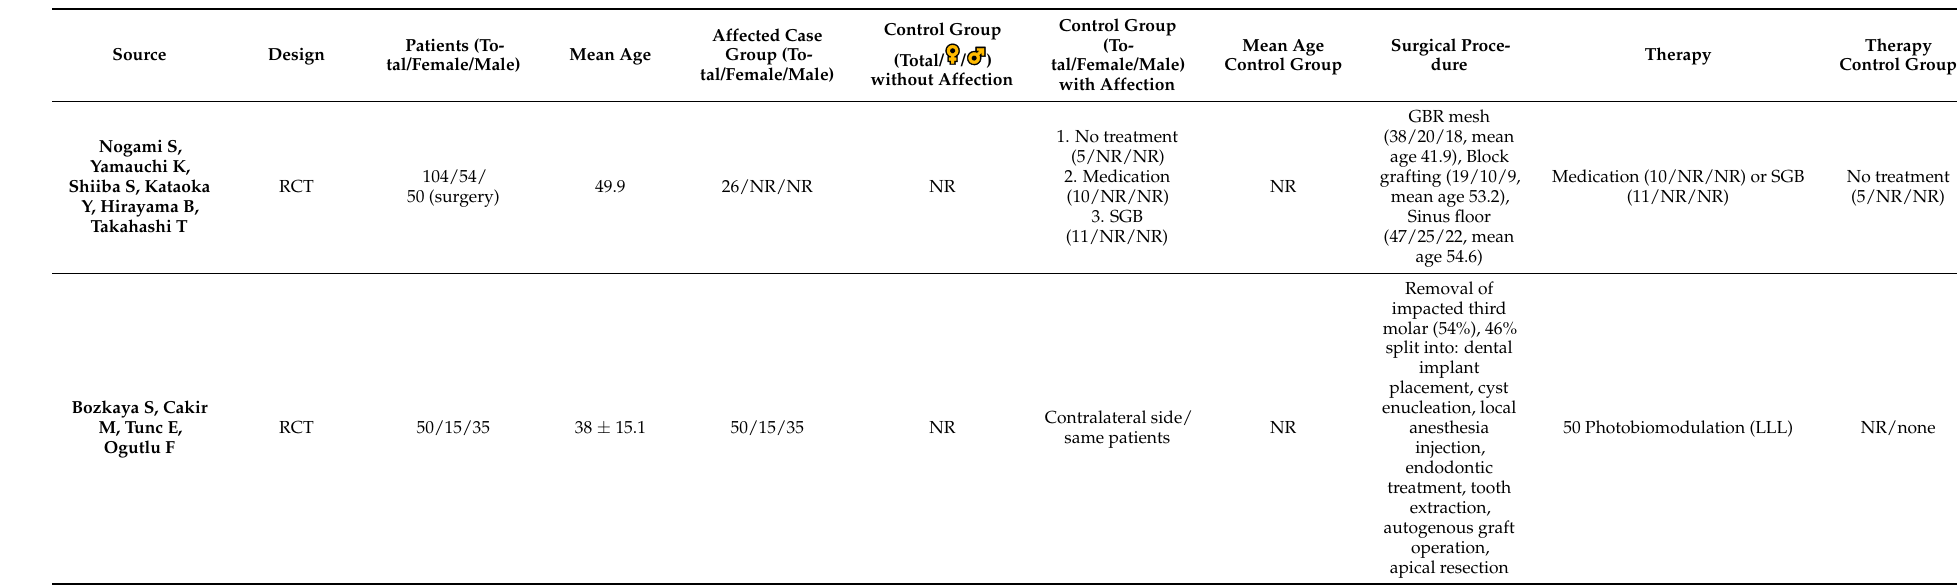
Table 4. Cont. Table 4. Demographic and clinical characteristics. Table 4. Demographic and clinical